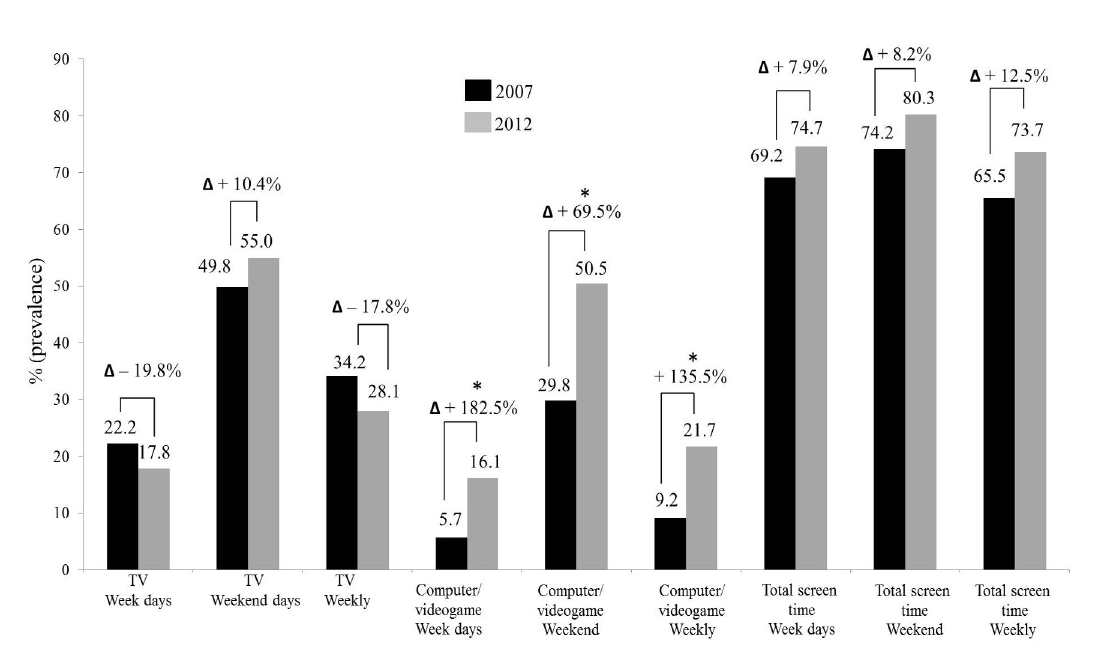
Figure 1. Prevalence of exposure (≥3 hours / day) to the different screen-based devices and total screen time, considering weekdays and weekend days in high school students of the public school network of Caruaru, PE, 2007 and